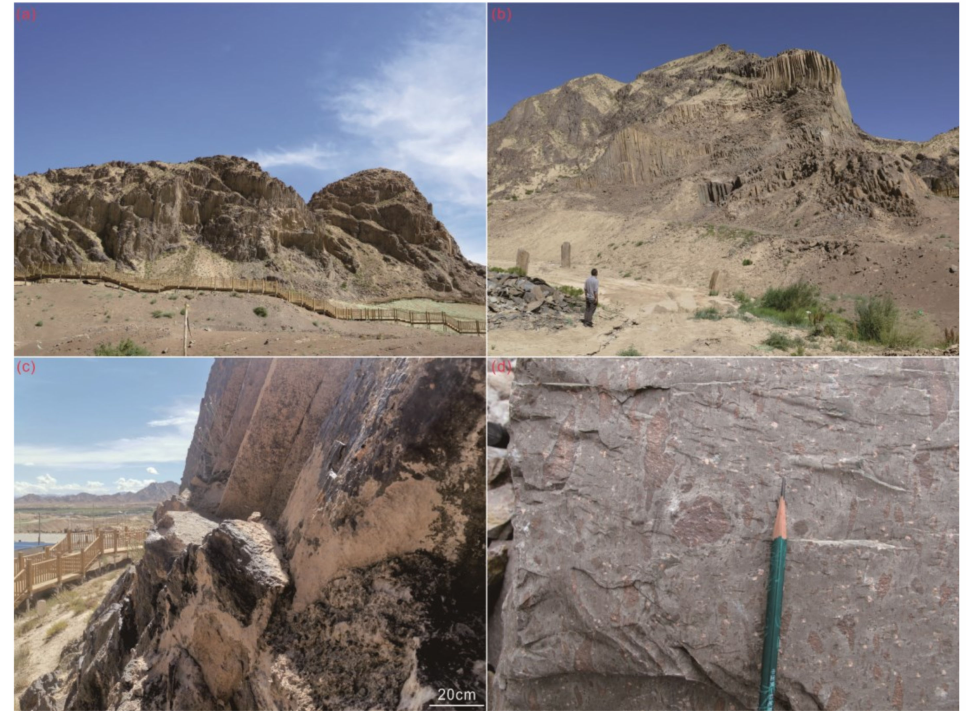
Figure 3. Field photographs and photomicrographs of the Keri rhyolites in the EKOB. ( a , b ) Field photographs of the Keri rhyolites; ( c ) columnar joints of rhyolitic tuff lavas; ( d ) field photos of the rhyolitic brecciated tuff